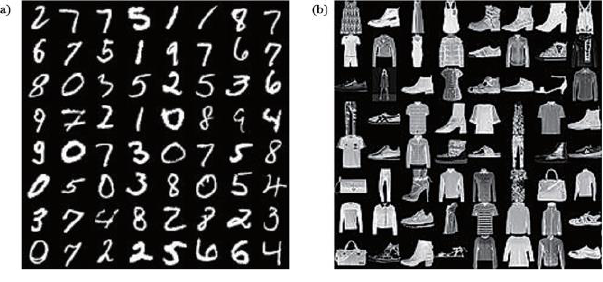
Figure 4. Some samples in MNIST and Fashion-MNIST Table 2. Number of channels and core size of auto-encoder network